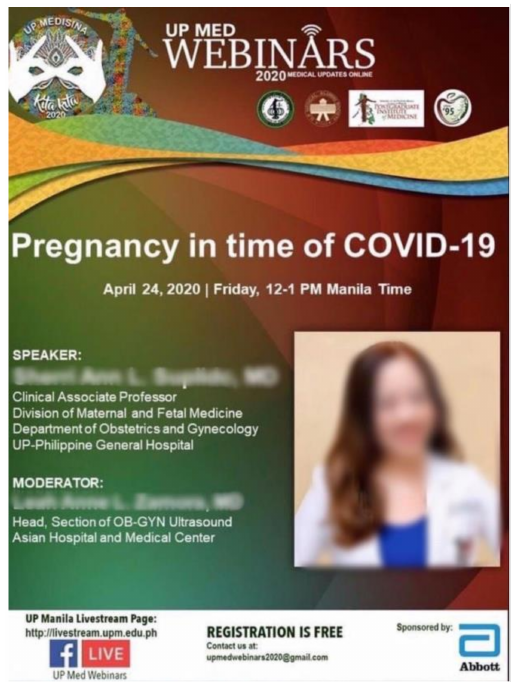
Figure 11. Screenshot of a webinar on pregnancy and COVID-19 organized by Abbott and the Medical College of the University of the Philippines from